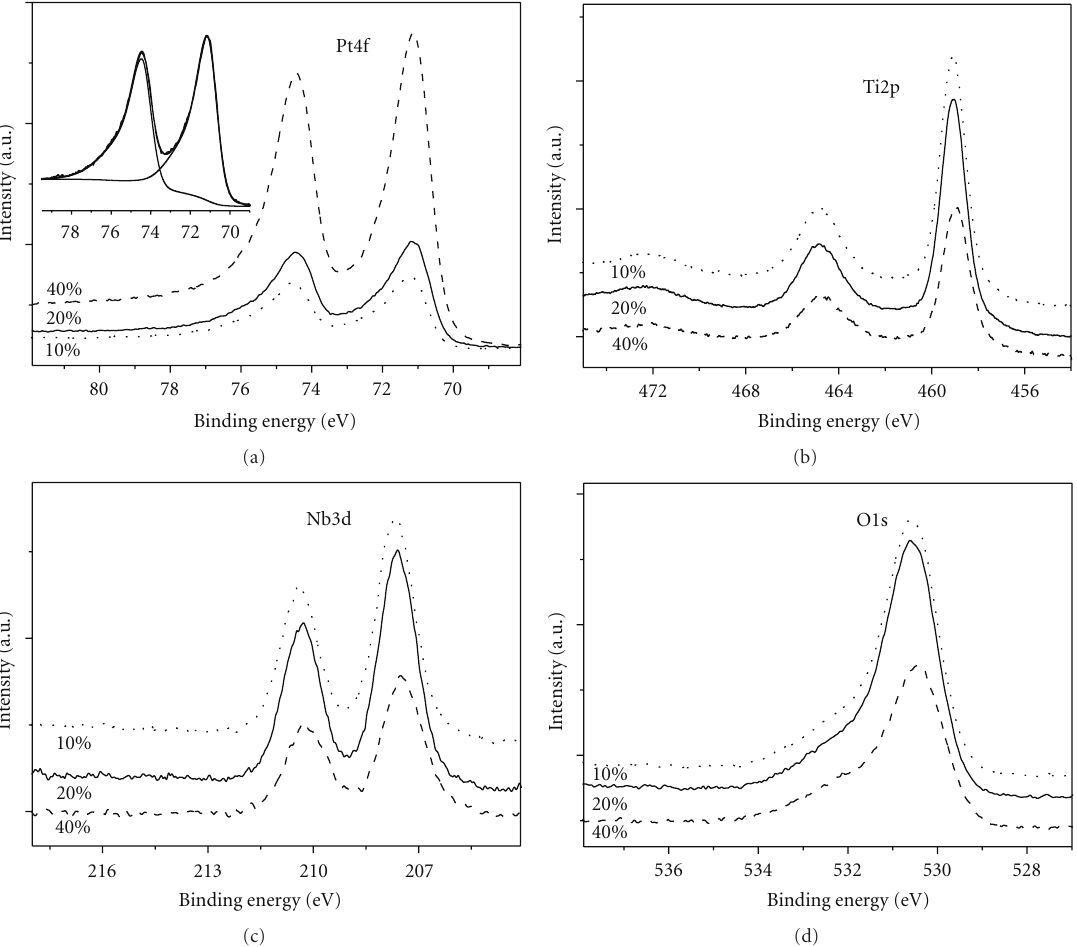
Figure 4: High-resolution XPS spectra of (a) Pt 4f; (b) Ti2p; (c) Nb3d; (d) O1S. Inset in (a) shows the corresponding deconvolution of Pt 4f spectrum.